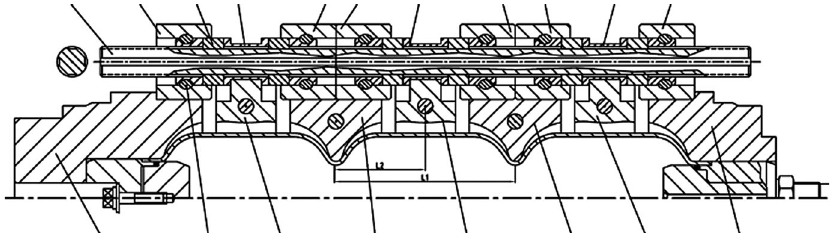
FIG. 15. Shape of the intermediate